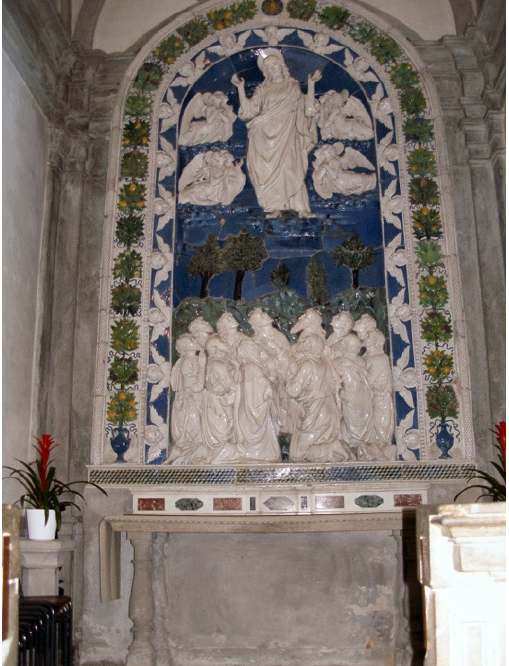
Figure 11. Andrea della Robbia, Ascension of Christ , enamel terra cotta, Chiesa Maggiore, La Verna (photo source: Gunnar Bach Pedersen, Public domain, via Wikimedia Commons).